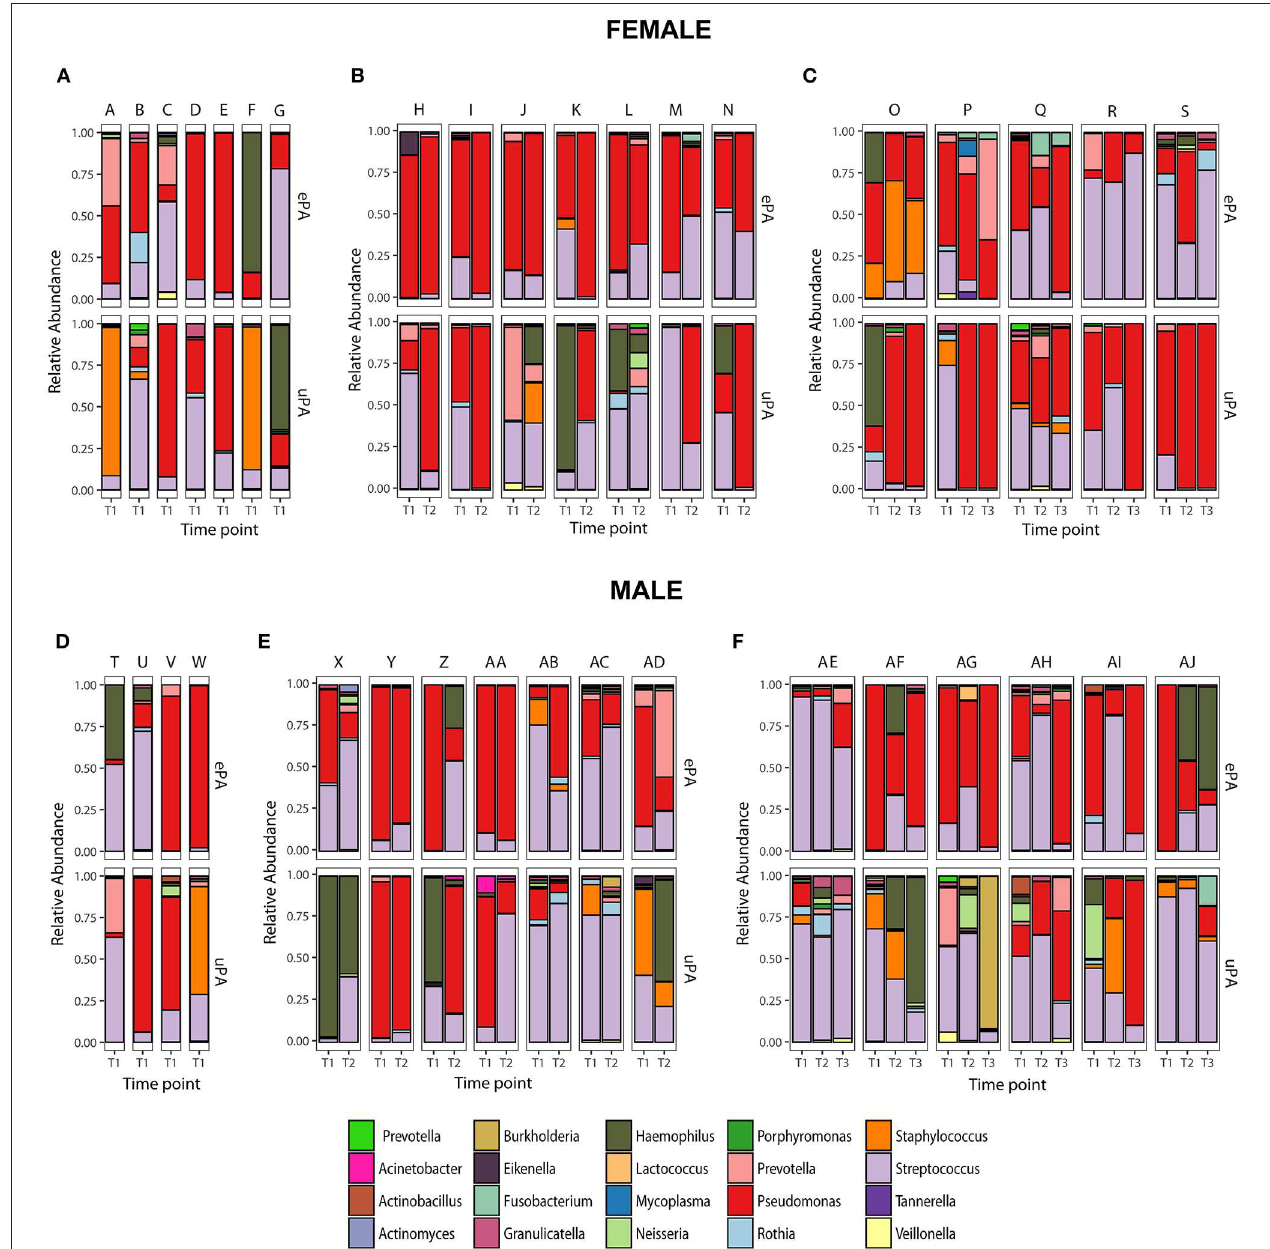
FIGURE 3 | Paired Microbiota from CF patients infected with epidemic (cases) and unique P. aeruginosa (controls) strains. Relative abundance at the genus level of 36 match set of samples (match ID denoted as letters) from CF patients (Female: upper panel and Male: lower panel) that were analyzed at only one time-point (T1) (A,D) , two time-points (T2) (B,E) and three time-points (T3) (C,F) . Top 20 genera accounting for > 0.2% of total abundance for the whole data set are colored and presented in the